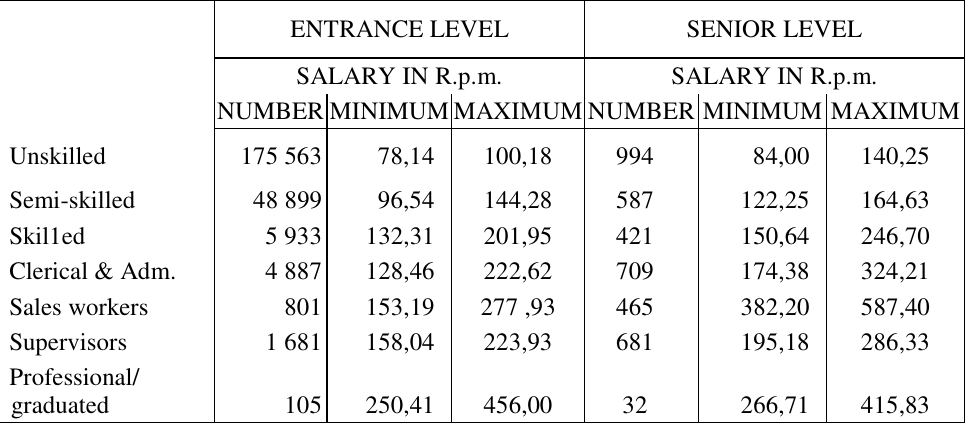
NUMBER OF BLACK WORKERS INVOLVED AND AVERAGES OF WAGE SCALES FOR DIFFERENT JOB CATEGORIES ENTRANCE LEVEL SENIOR LEVEL SALARY IN R.p.m. SALARY IN